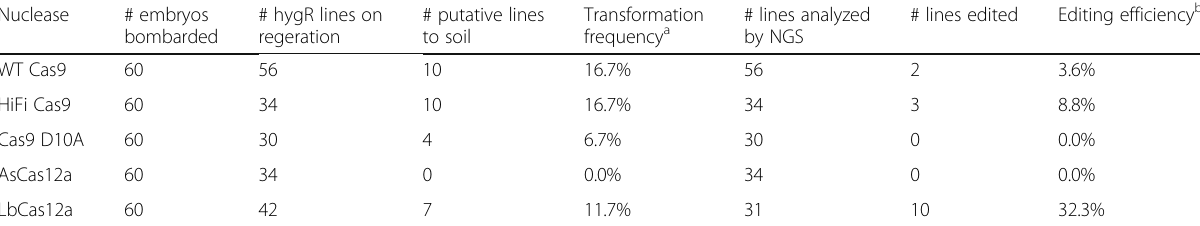
Table 2 Summary of transformation frequencies and editing efficiency for five CRISPR-RNP/selectable marker plasmid co-delivery